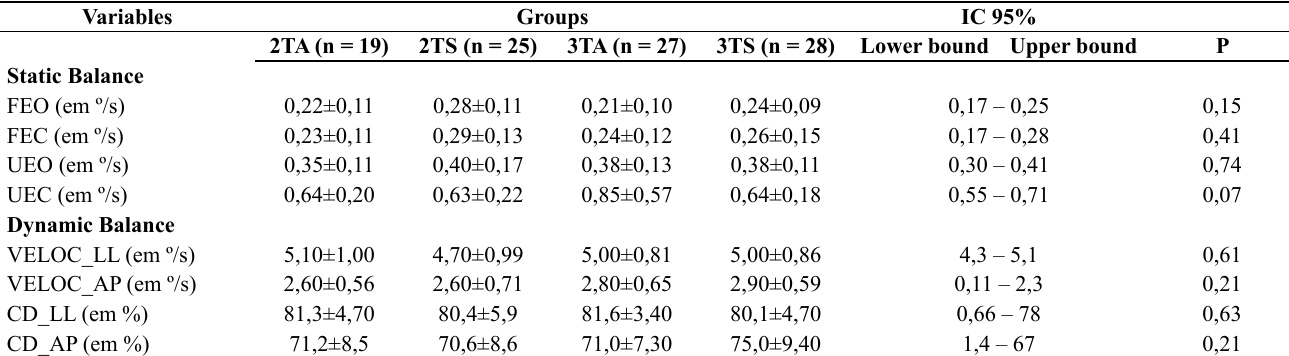
Figure 1 – Analysis of postural sway velocity on the firm surface and open eyes, when comparing the active and sedentary women. *P < 0.05 Table 3- Behavior analysis of the variables of postural balance, with gestational trimesters and physical activity as grouping factors. Variables